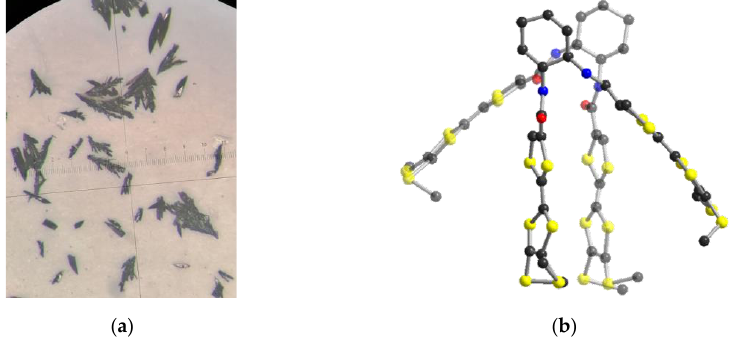
Figure 8. View of crystals ( a ) and the partial structure of ( rac )- 1 in the radical cation salt with AsF 6 ⁻ ( b ). The anions were omitted due to insufficient crystallographic data.